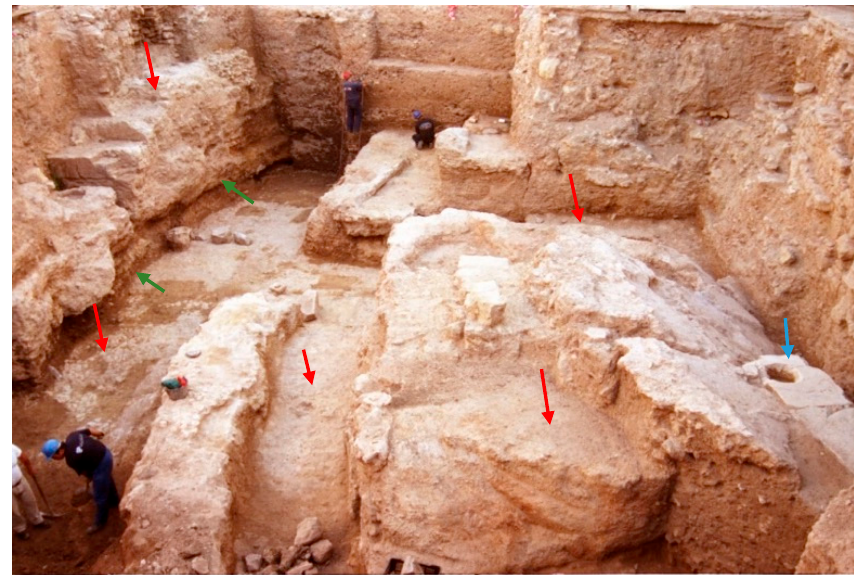
Figure 8. Ima cavea (lower seats) of the Roman theatre of Cordoba excavated in the quaternary terrace of the Guadalquivir River. Blue arrows indicate the ancient marble seats of theatre. Red arrows indicate the quaternary terrace. Green arrows indicate geological marls. © Antonio Monterroso-Checa.